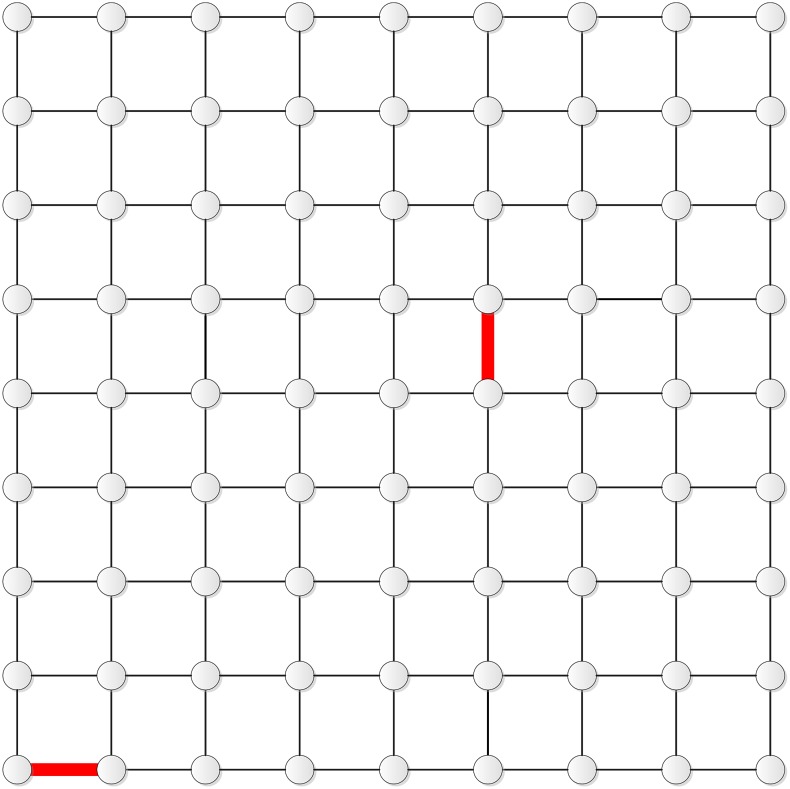
The two edges in T9.